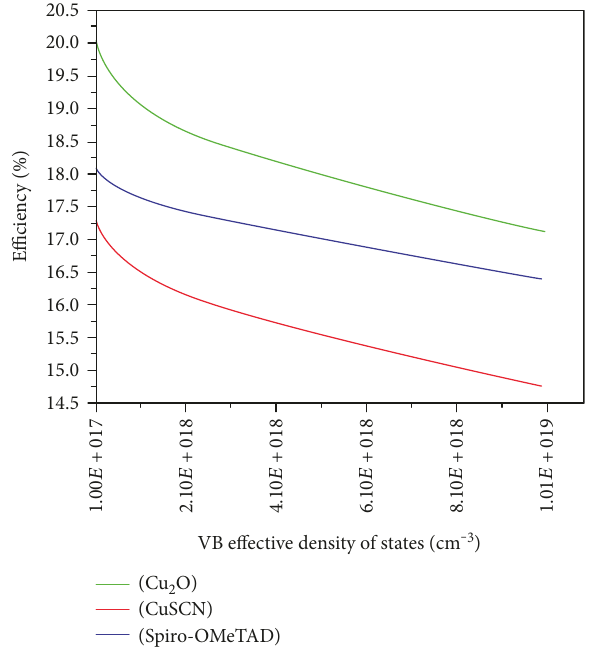
Figure 7: Valance band e ff ective density of state versus e ffi ciency.